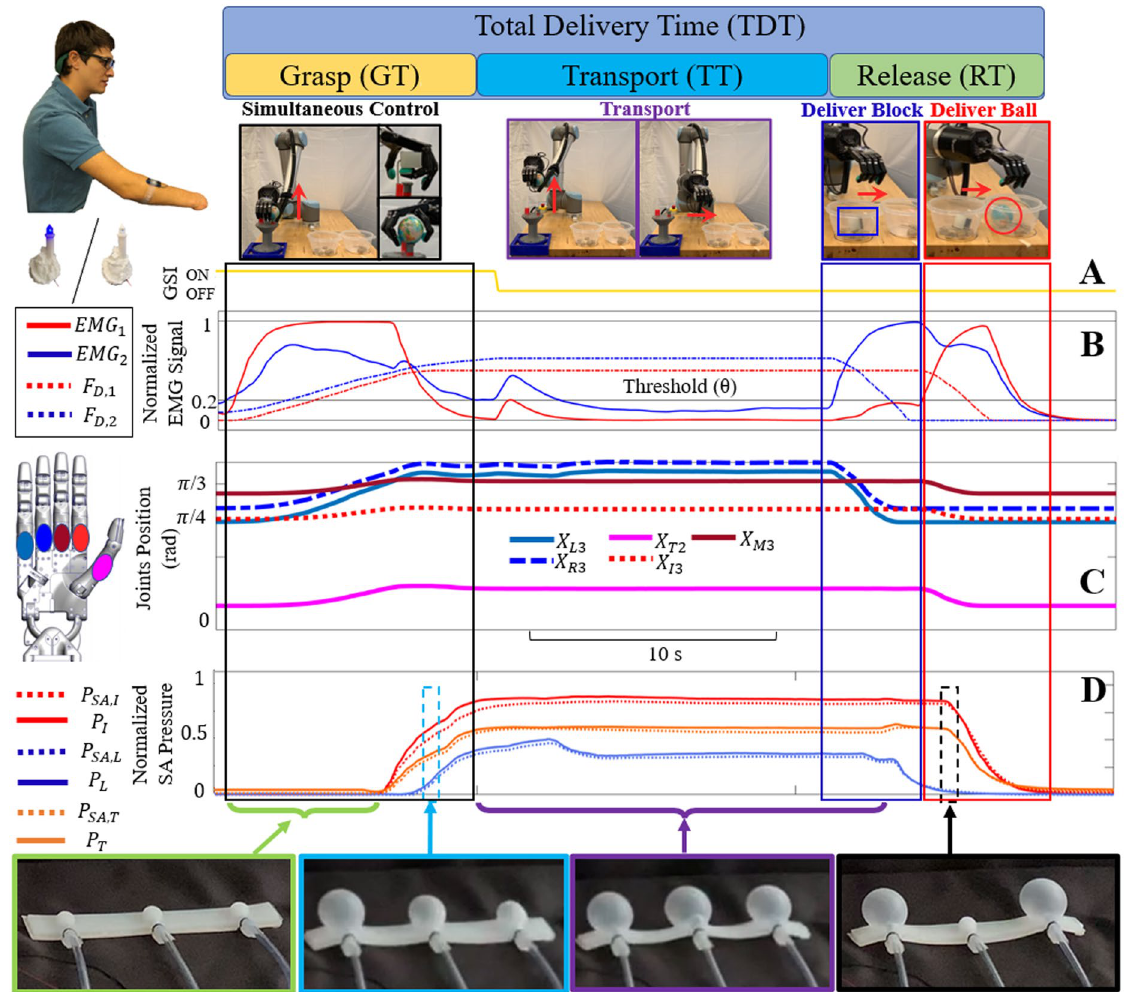
Figure 8. Exemplary trial showing afferent and efferent signals during grasp, transport and delivery of two objects simultaneously (see also Fig. 2A–D for photographic correlation to the sequence of actions). ( A ) The grasp state indicator (GSI) showing open/close state of the hand. ( B ) EMG signals were simultaneously co-activated at the beginning of the trial to grasp both objects. A rapid co-contraction of EMG signals toggled the GSI to switch from the opening mode to the closing mode of the hand. Then EMG 2 was increased followed by EMG 1 to deliver the block and ball to their respective locations. ( C ) Selected joint angles of the hand increased and then decreased as the two grasps of the hand were closed and opened to grasp, transport, and release the objects. ( D ) Haptic feedback signals increased after the objects were contacted to stably grasp both the ball and block. Then the pressure levels in the soft robotic armband decreased sequentially as the two objects were